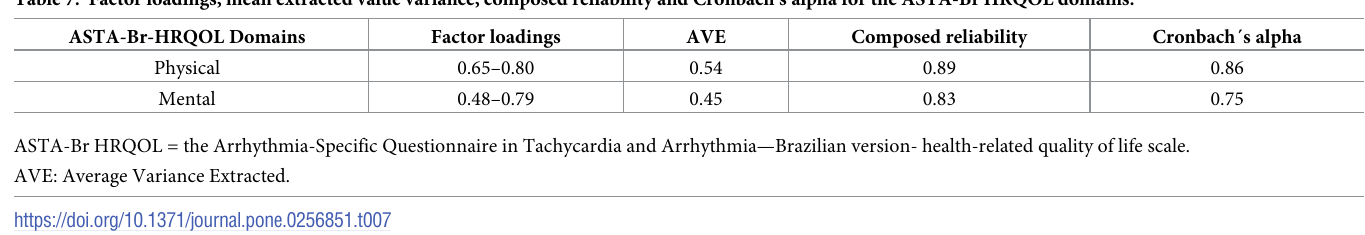
Table 7. Factor loadings, mean extracted value variance, composed reliability and Cronbach’s alpha for the ASTA-Br HRQOL domains. ASTA-Br-HRQOL Domains